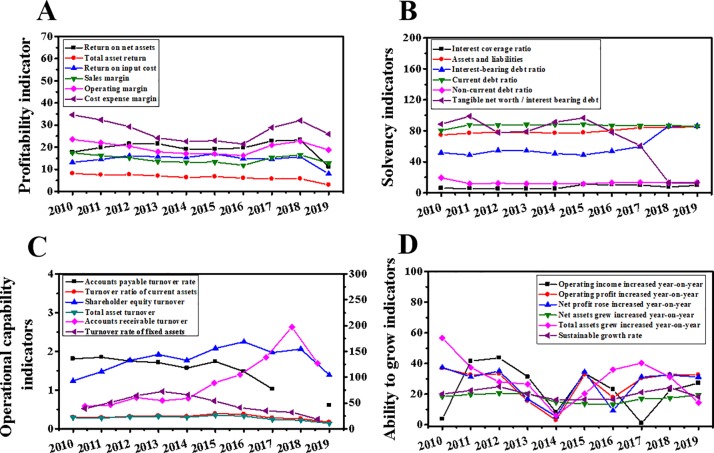
Changes in the development capacity of listed company A from 2010 to 2019.(A is profitability; B is the debt risk; C is the operating capacity of assets; D is development ability.).